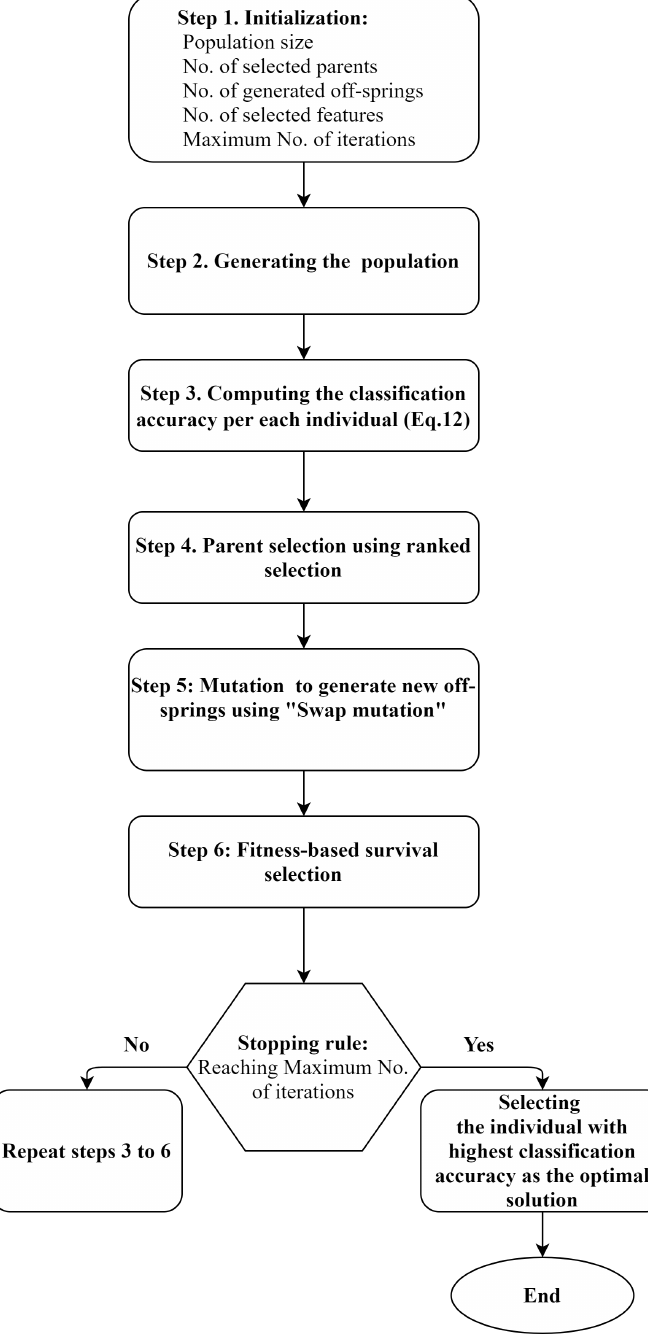
Figure 3. The proposed GA algorithm for feature